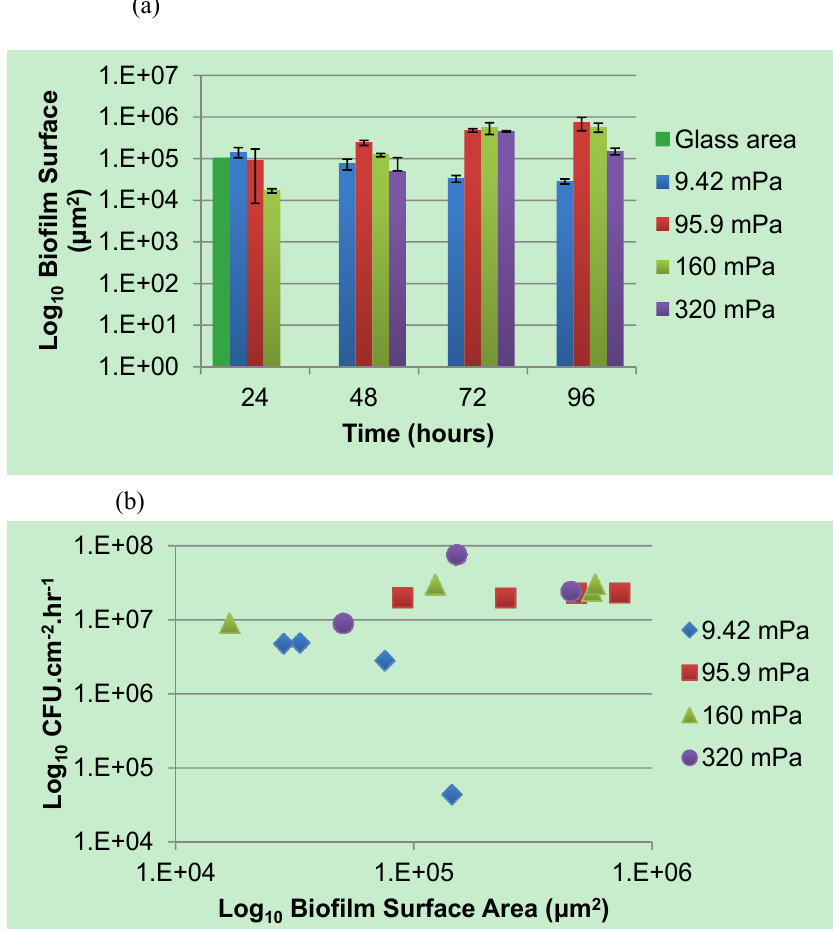
Figure 5. ( a ) The area of the biofilm ( μ m 2 ) exposed to the bulk-liquid environment was calculated for each Z-stack from data obtained after COMSTAT analysis of the CLSM images. The grey bar indicates the area of the glass substratum; note that the incomplete coverage of the glass surface, and the patchy nature of biofilms as evident in Figure 3, explains why the area of the glass surface often exceeds that of the biofilms; ( b ) The CFU.cm − 2 h − 1 ) and the surface relationship between the average cell production rate (Log 10 area of the biofilm (Log μ m 2 ) exposed to the bulk-liquid, for biofilms developed at 10 4 different average shear